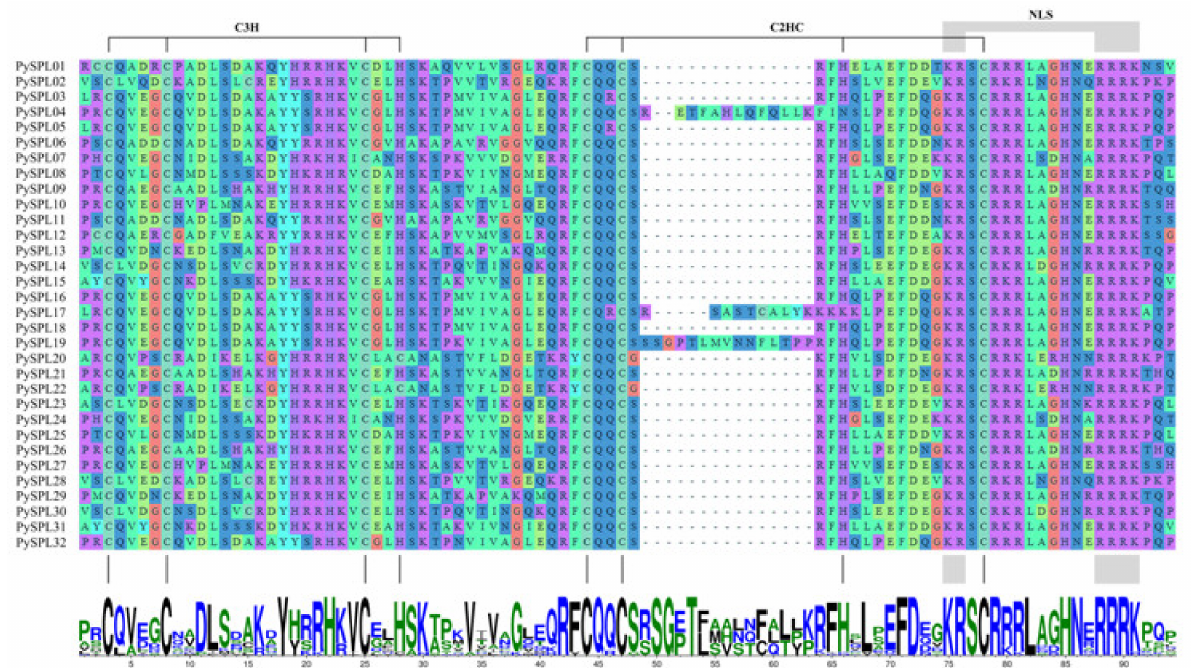
Figure 3. Alignment and conserved domains logo of conserved domains sequence of PySPLs pro- tein.C3H and C2HC were two zinc-finger structures, NLS was bidirectional nuclear localization signal, which were corresponding to the sequence logos of conserved domains.